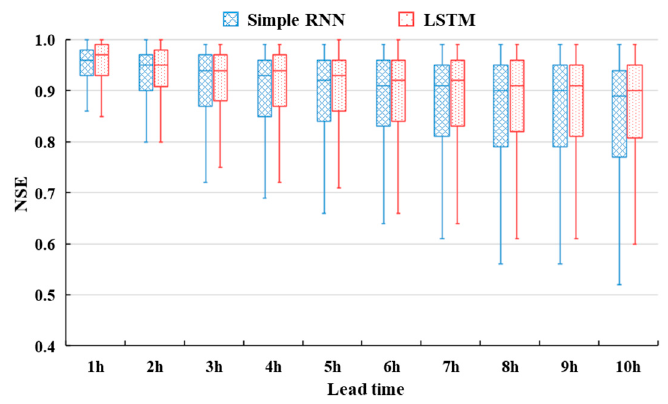
Figure 12. NSE for di ff erent RNN approaches at 1–10-h lead-time.